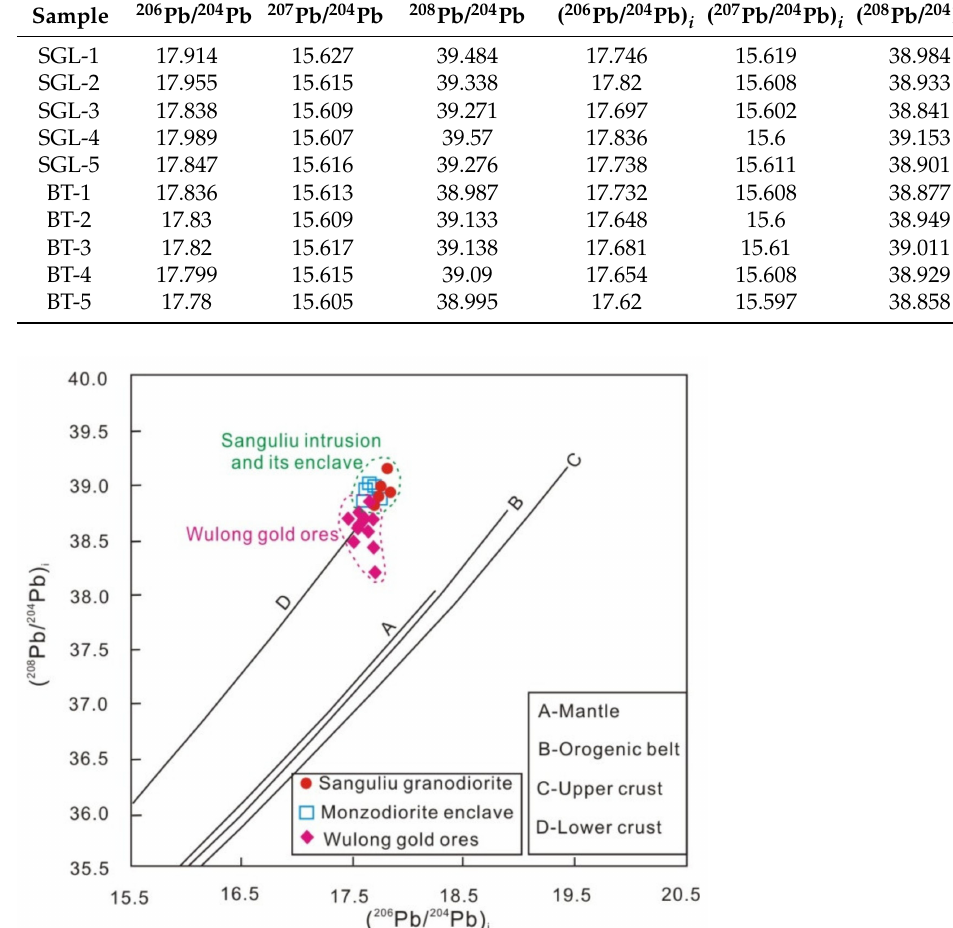
Figure 11. ( 206 Pb/ 204 Pb) i versus ( 208 Pb/ 204 Pb) i diagram (modified from [63]). The data of the Wulong gold deposit are from